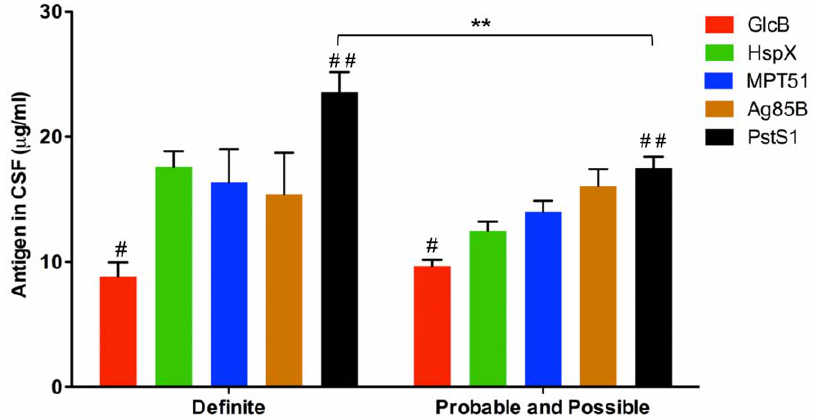
Figure 5. Antigen concentrations in TBM CSF filtrates. # GlcB concentration was significantly lower (p , 0.05) than that of HspX, MPT51 and PstS1 in ‘Definite’ TBM and all 4 antigens in ‘Probable and Possible’ TBM groups; ## PstS1 concentration was significantly higher (p , 0.05) within both ‘Definite’ (all antigens) and ‘Probable and Possible’ TBM (all antigens except Ag85B) groups. **PstS1 concentration was also significantly higher (p , 0.01) in ‘Definite’ TBM group vs. ‘Probable and Possible’ TBM groups.